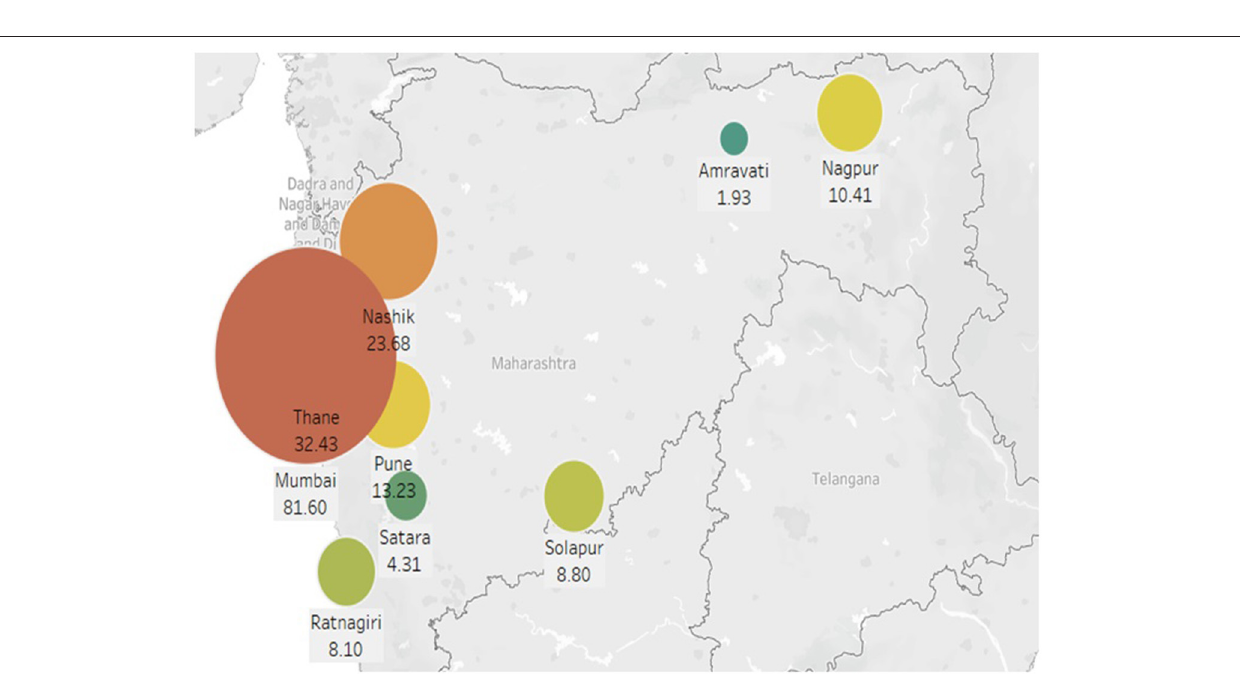
FIGURE 9 | Monthly average incidence hotspot